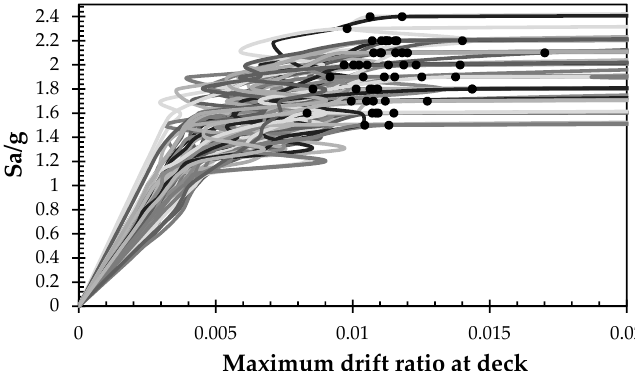
Figure 5. Structural capacity due to earthquakes.